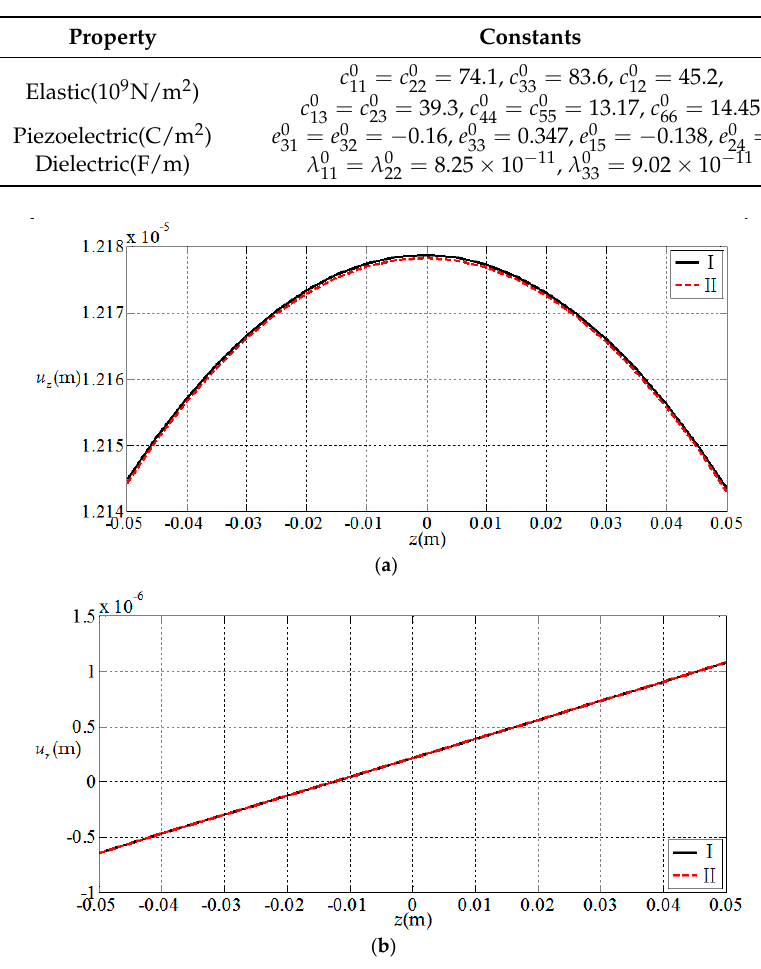
Figure 2. Variation of elastic displacements with coordinates z , where I denotes the solution presented in this study; II denotes the solution presented in [32]. ( a ) z -direction displacement at the center of plate u z ( 0, z ) ; ( b ) radial displacement at the periphery of plate u r ( 1, z )